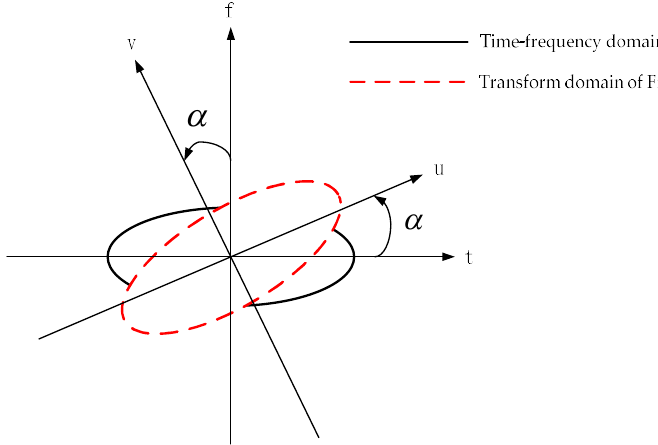
Figure 1. The rotation transformation diagram of the fractional domain.